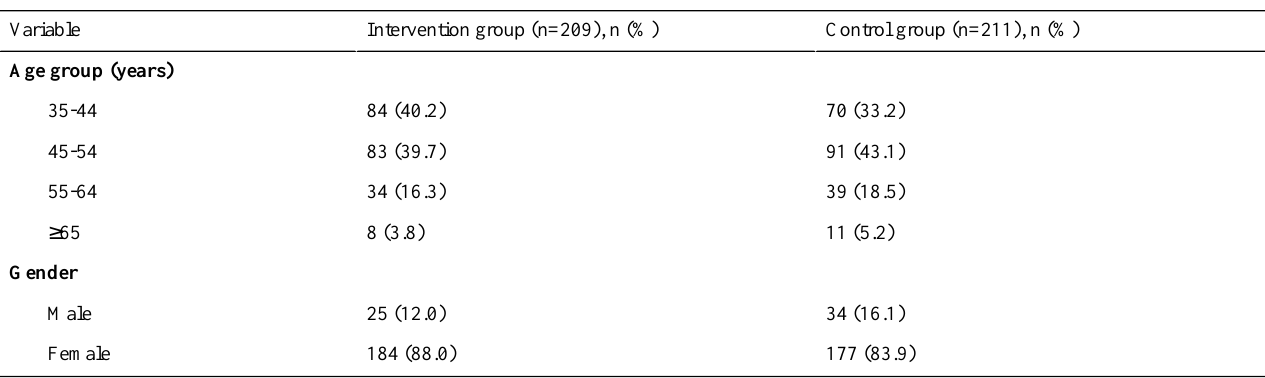
Table 3. Age-sex breakdown of study